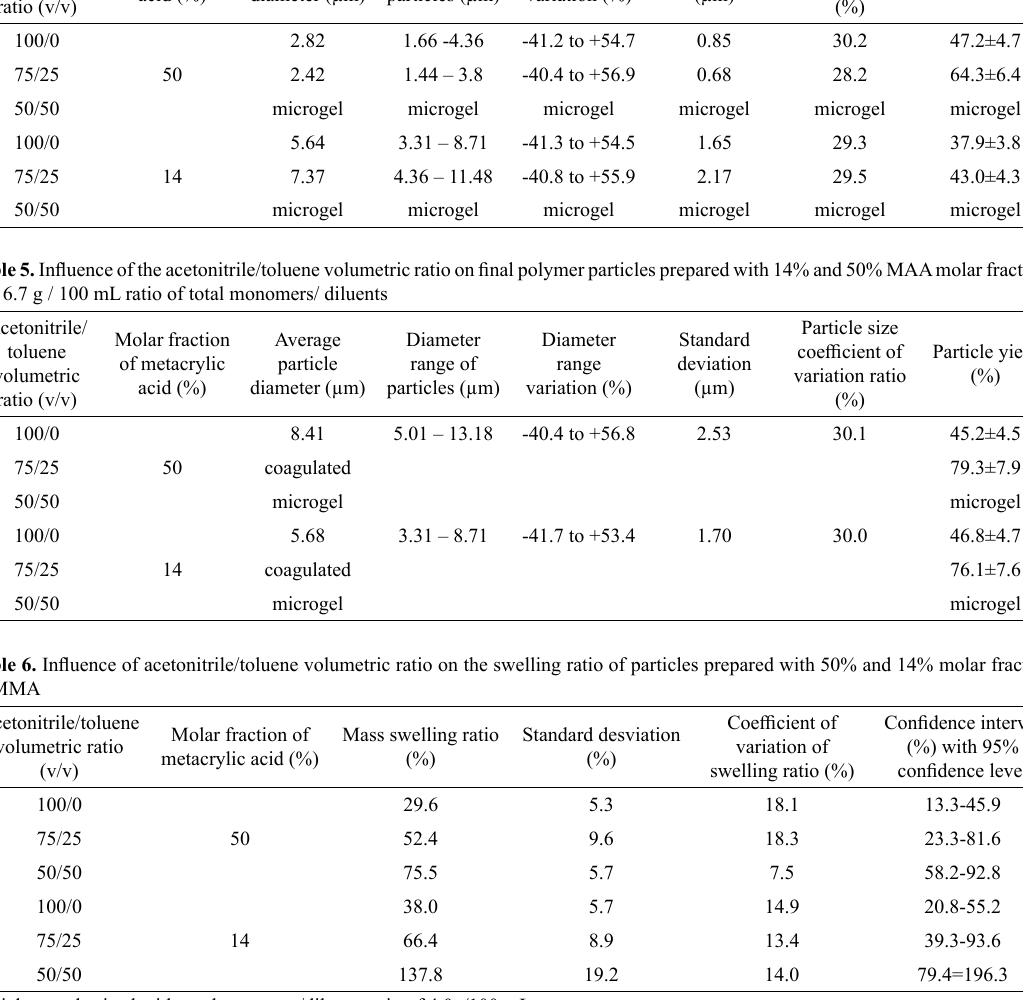
Table 4. Influence of the acetonitrile/toluene volumetric ratio on final polymer particles prepared with 14% and 50% MAA molar fraction, and 4.0 g / 100 mL ratio of total monomers/ diluents Acetonitrile/ toluene volumetric ratio (v/v)